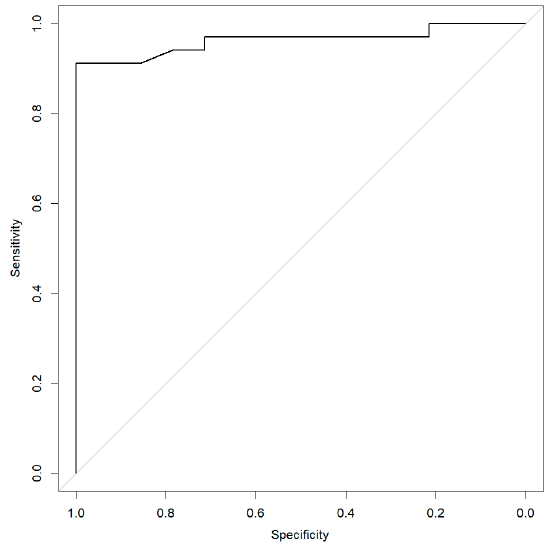
Figure 3. Receiver operating characteristic curve (ROC) analysis. Sensitivity and specificity of anti- fibrillarin antibody (AFA) levels for the diagnosis of SSc were optimal for a cut-off value of 115 U/mL.